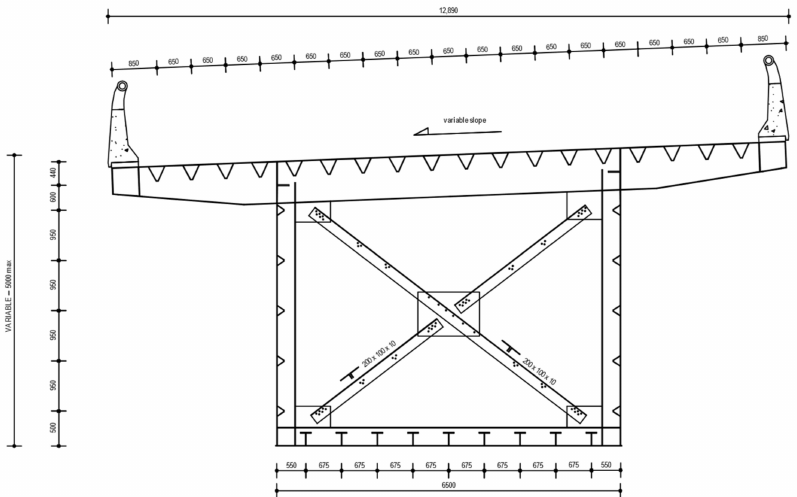
Figure 12. Transversal section of the case